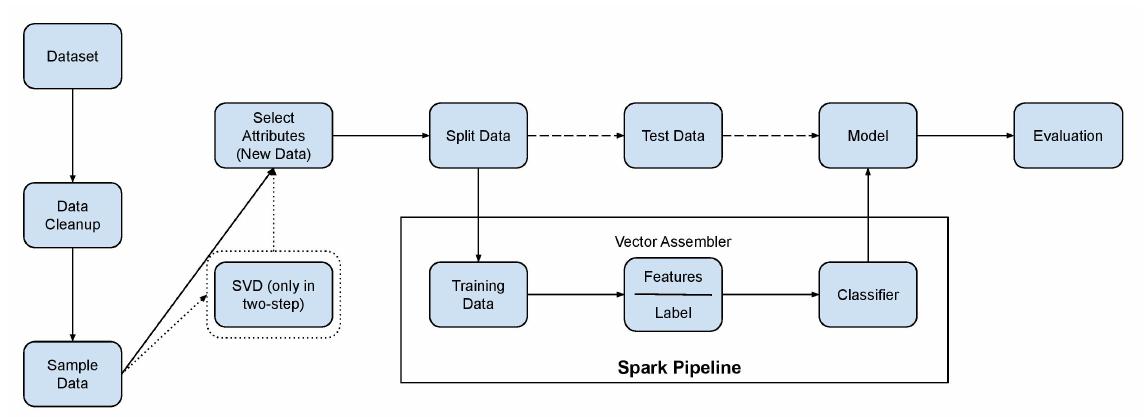
Figure 2. Proposed system architecture.